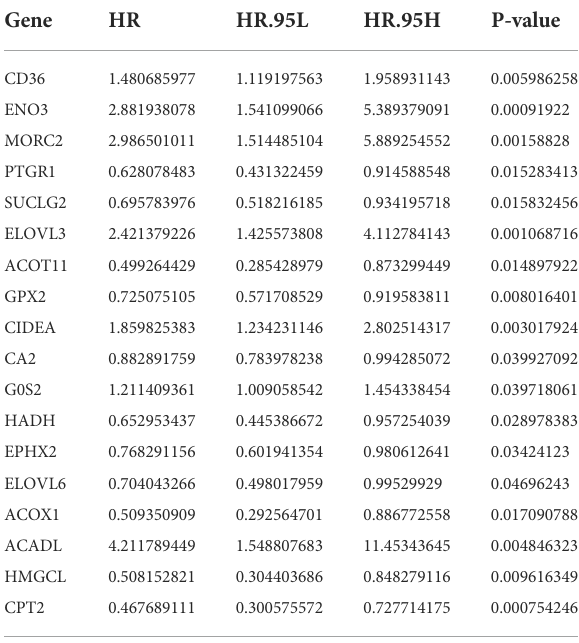
TABLE 1 Univariate Cox regression analysis of FAM-related genes in